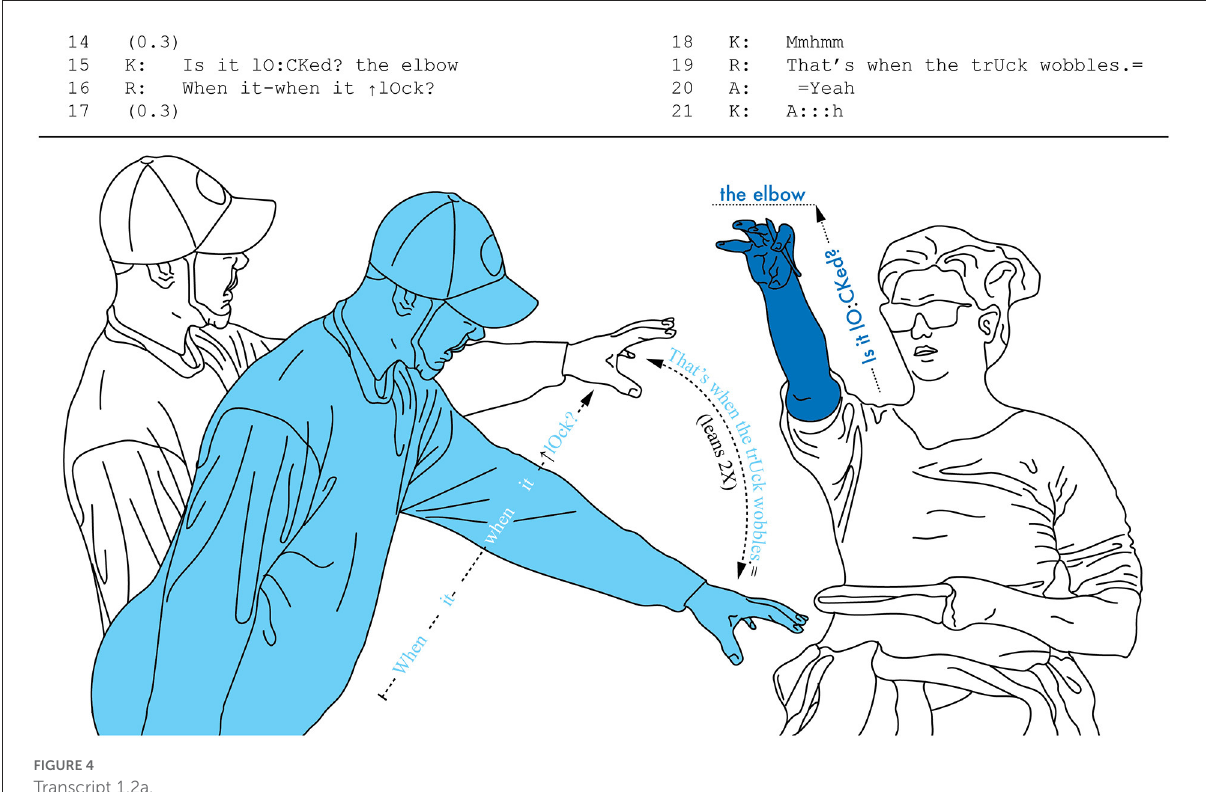
FIGURE4 Transcript